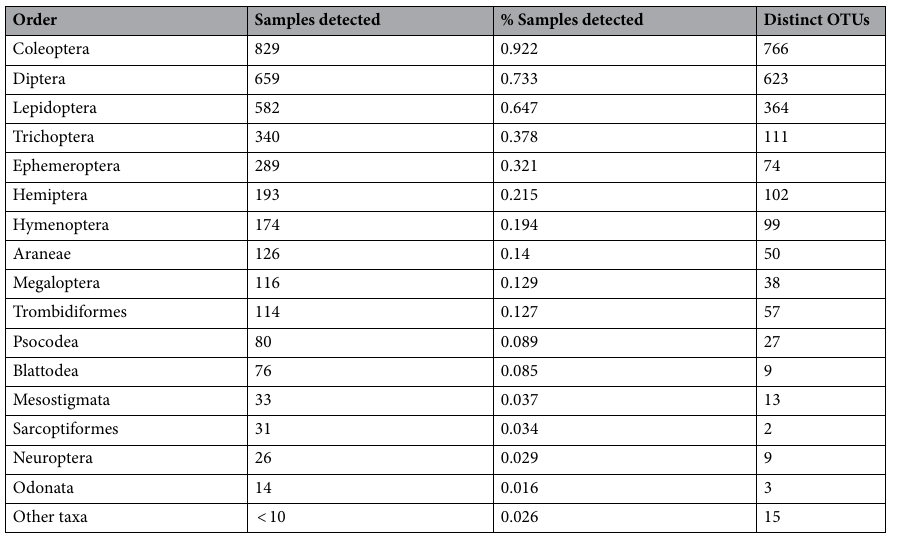
Table 1. Number and fraction of samples with a sequence variant (OTU). OTUs are classified to a particular arthropod order among all bat guano samples collected in 2015 and 2016 throughout 19 sites in New Hampshire, USA. OTUs were clustered by collapsing exact sequence variants at 98.5% identity. Orders with fewer than ten samples detected included: Entomobryomorpha (4 samples), Plecoptera (4), Thysanoptera